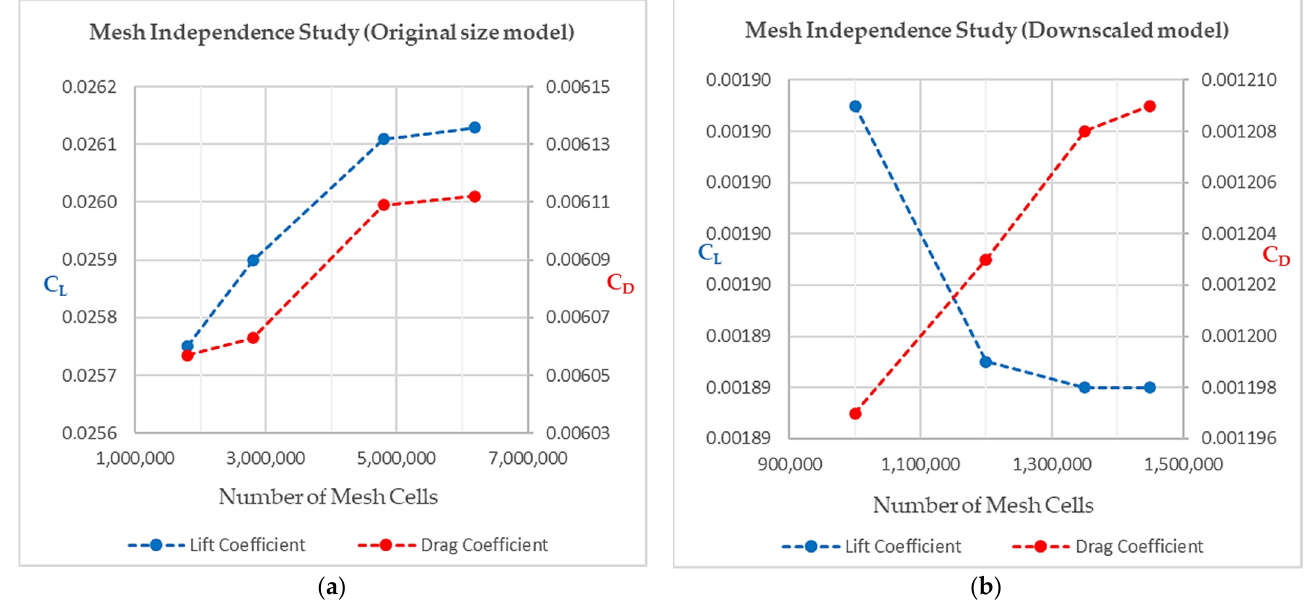
Figure 4. ( a ) Mesh independence study for lift and drag coefficients, at 0° angle of attack, of the wing model with original dimensions; ( b ) mesh independence study for lift and drag coefficients, at 0° angle of attack, of the downscaled wing model.